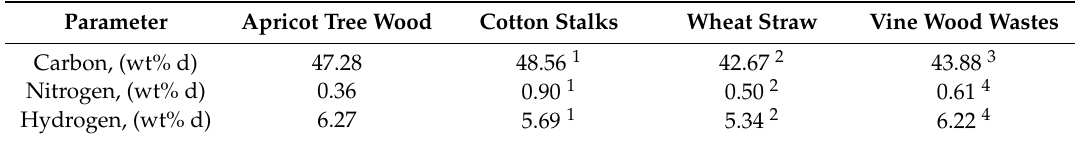
Table 3. Content of carbon, nitrogen and hydrogen in tested apricot biomass in comparison with other biomass materials.